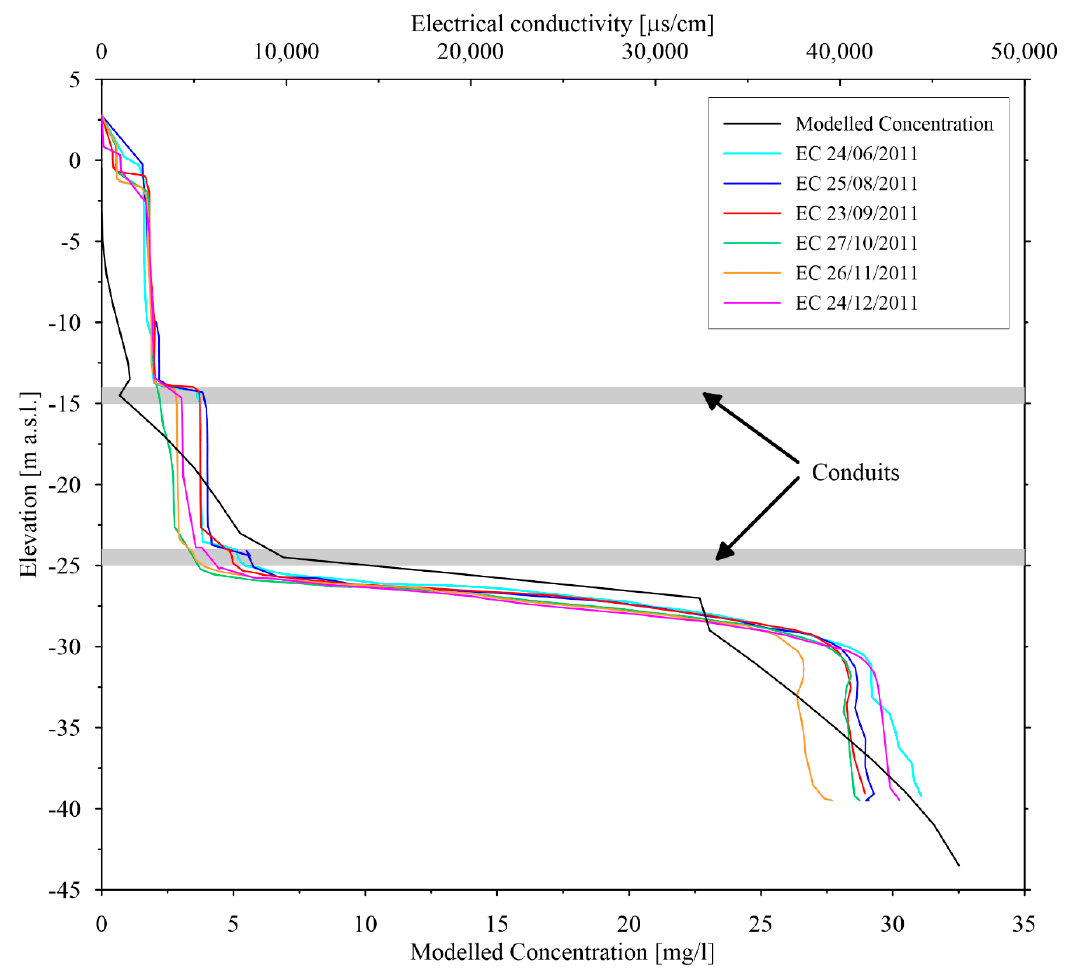
Figure 11. Concentration computed by the numerical model (black line) and electrical conductivity (coloured lines) observed at well 18.